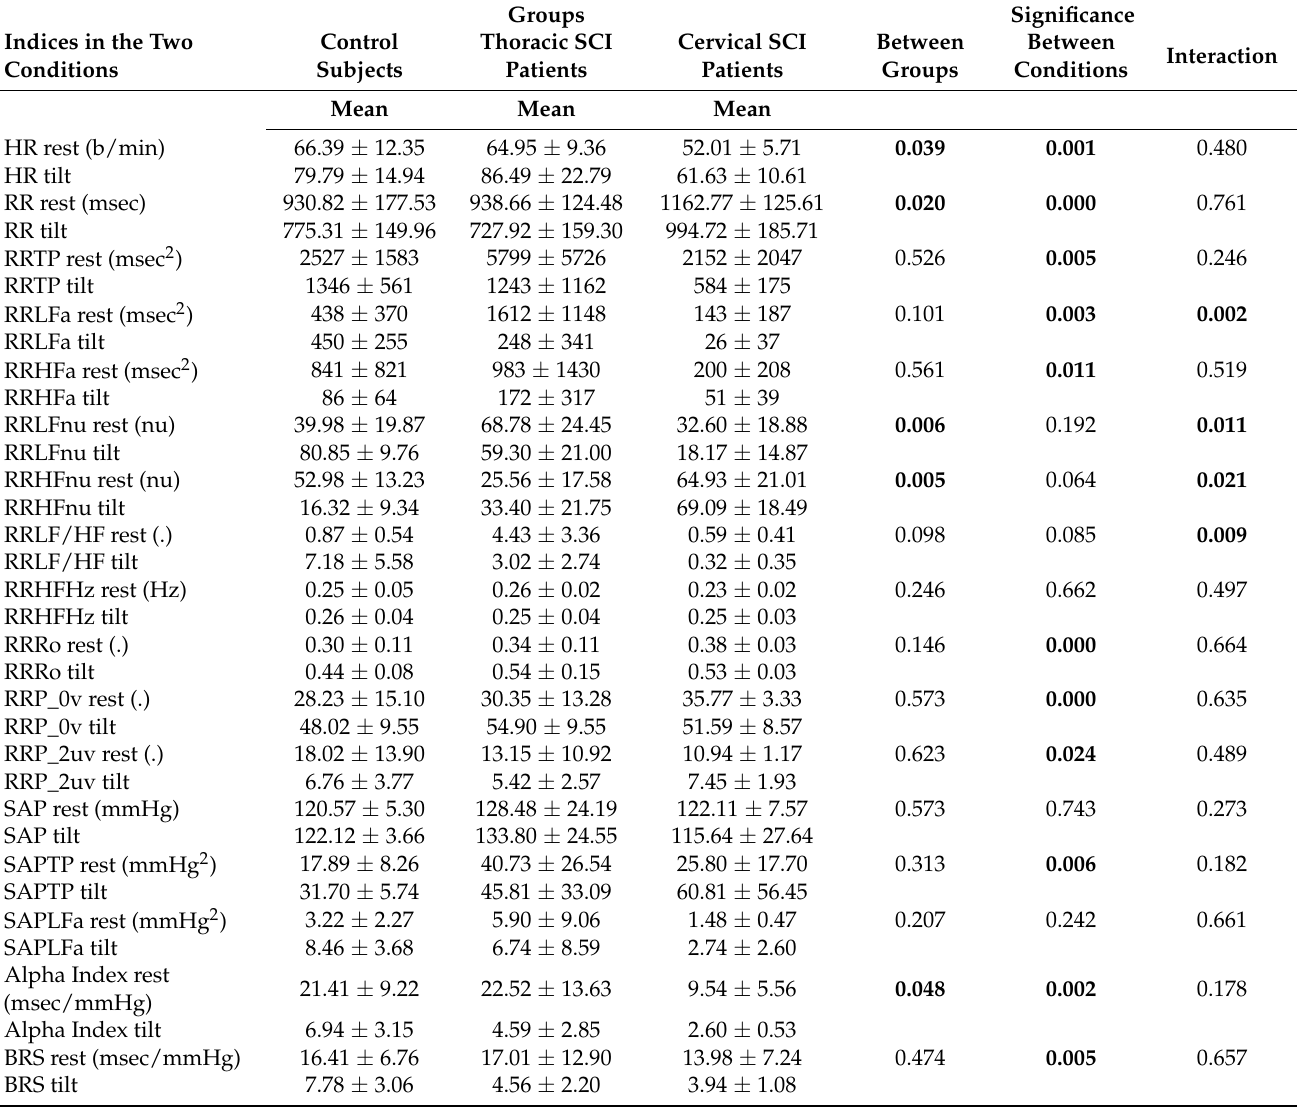
Table 2. Summary descriptive data of the three study groups during Rest and Tilt